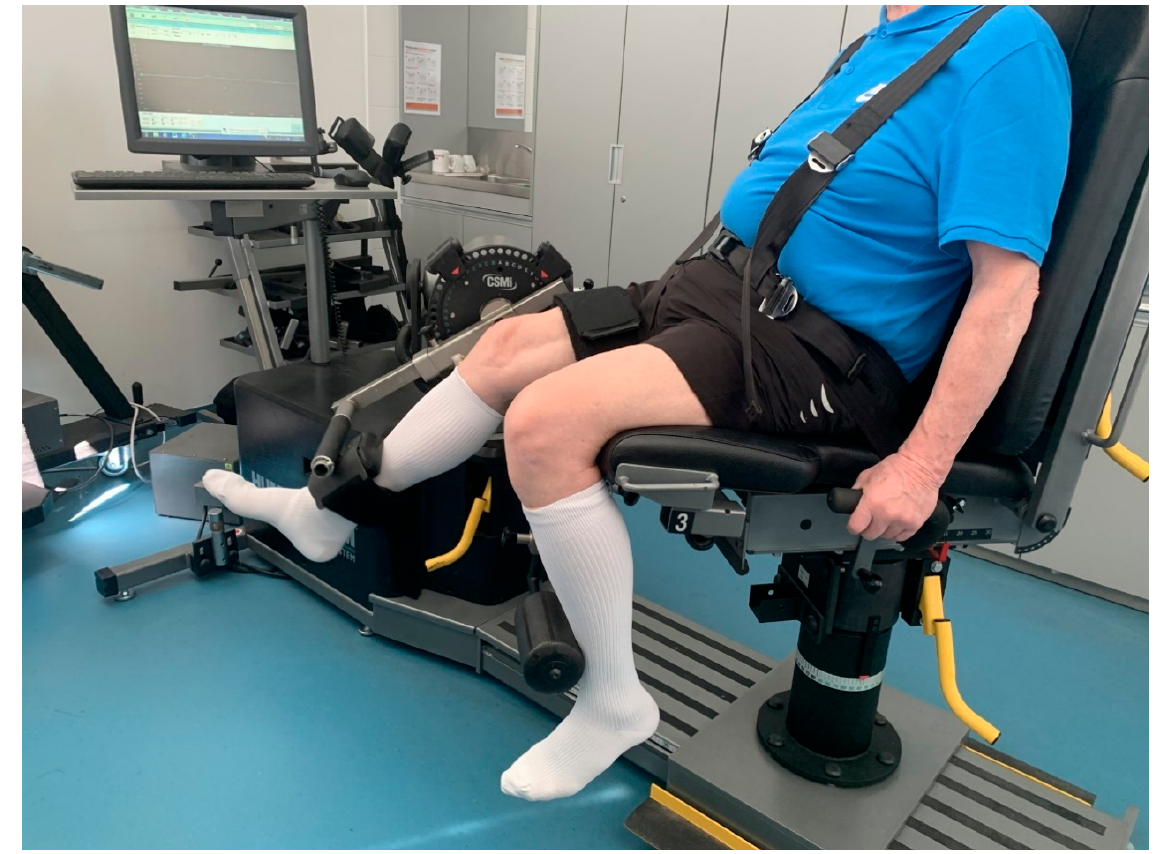
Figure 1. Assessment of isokinetic knee strength testing.